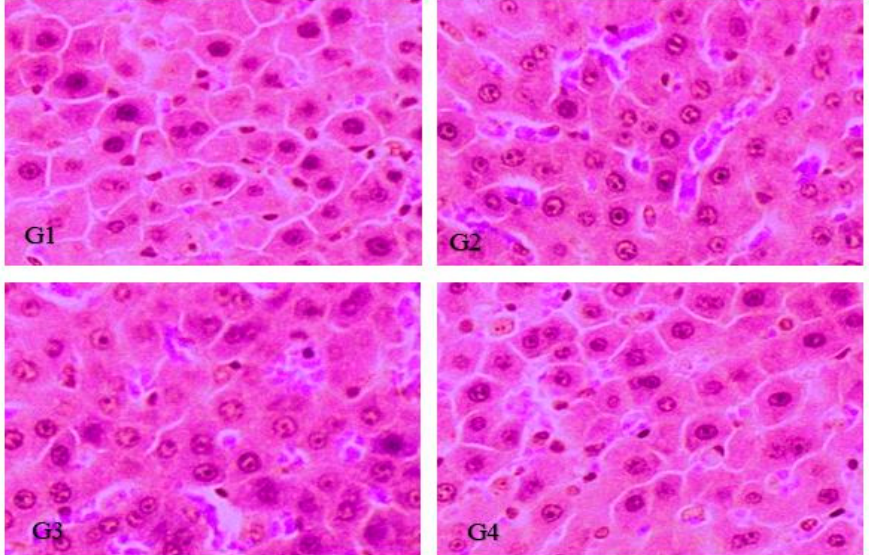
Figure 8. Histopathological examination of the liver by using H & E staining. ( G1 ) Normal control without any treatment, ( G2 ) treatment with 0.5 mL (product) immunized by IP without significant changes in hepatic cells, ( G3 ) treatment with vehicle control 0.5 mL (standard) immunized by IP without any significant changes in hepatic cells, ( G4 ) positive control (market standard vaccine) 0.5 mL immunized by IP without any significant changes in hepatic cells.